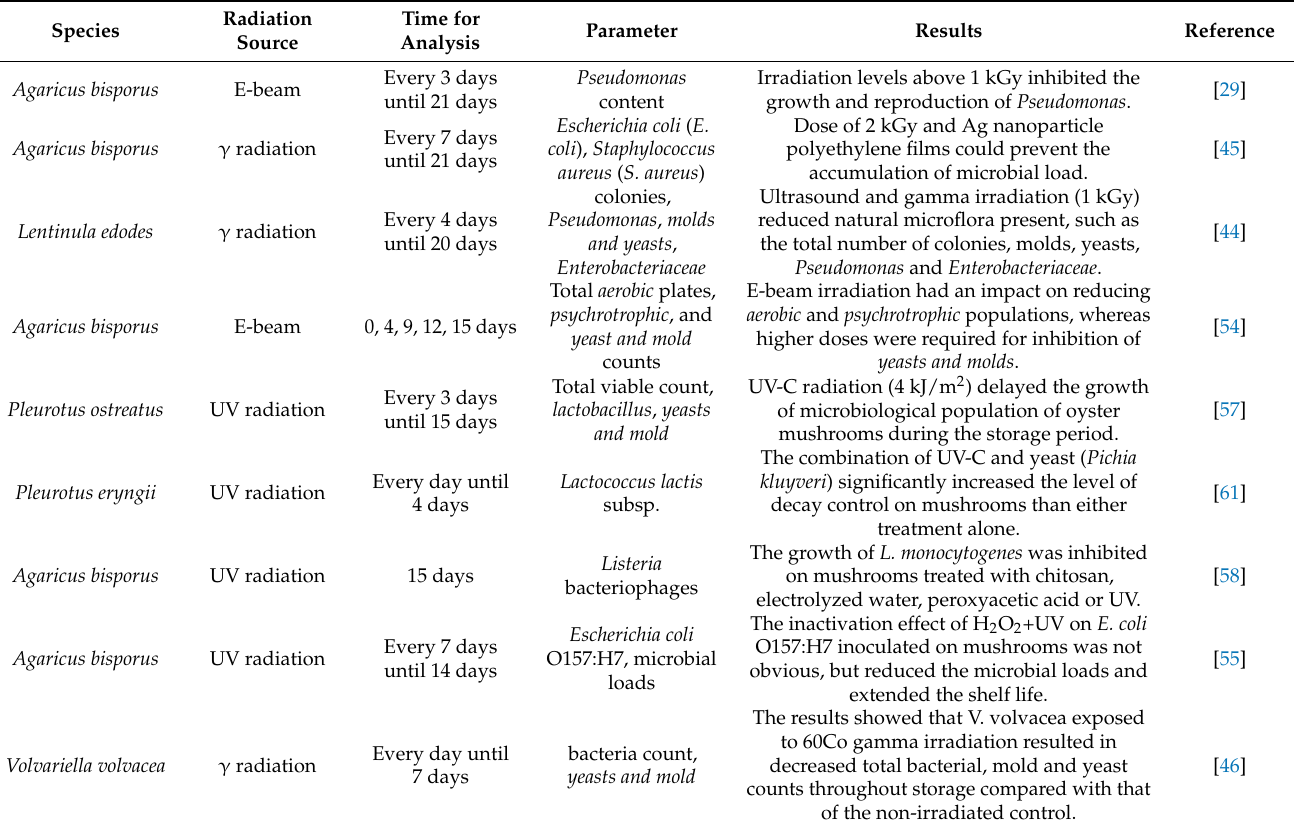
Table 2. Effects of radiation on the inhibition of pathogenic microorganisms of edible